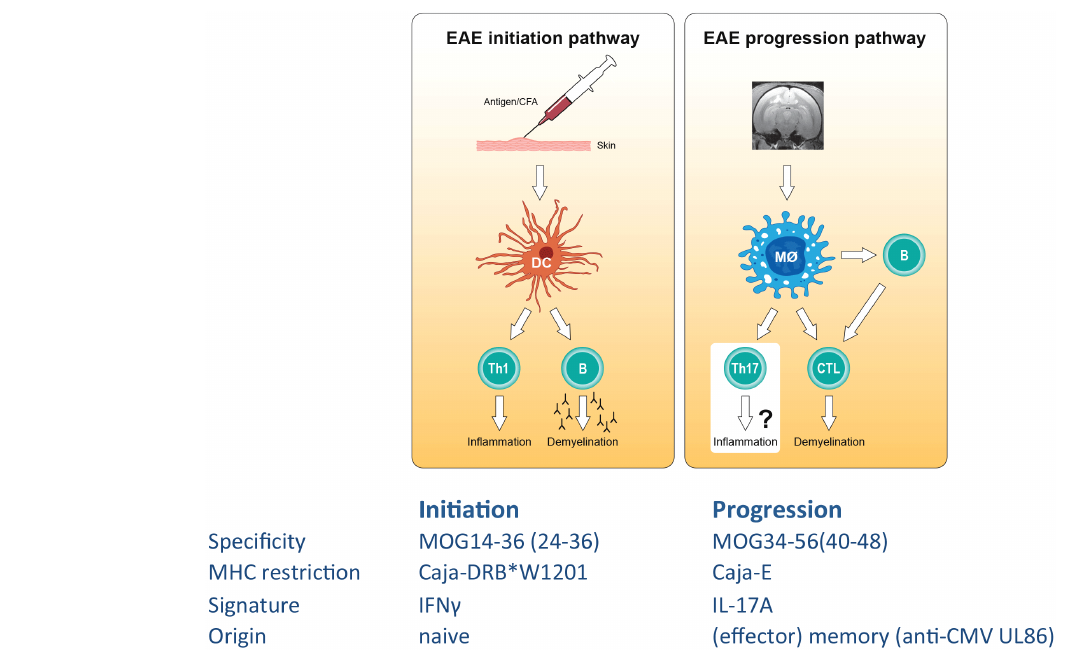
Figure 3. The two pathogenic pathways in the rhMOG/CFA-induced marmoset experimental autoimmune encephalomyelitis (EAE) model. In all marmosets immunized with rhMOG/CFA, initiation of EAE involves the activation of CD4 + T helper 1 cells specific for the epi- tope 24–36. Activation of the T cells is restricted by the monomorphic allele Caja-DRB*W1201, which all marmosets have in common. After a variable period of time CD4 + CD8 + CD56 + cytotoxic T cells specific for the epitope 40–48 are activated; activation is restricted by the invariant non-classical MHC class Ib allele Caja-E, which all marmosets have in